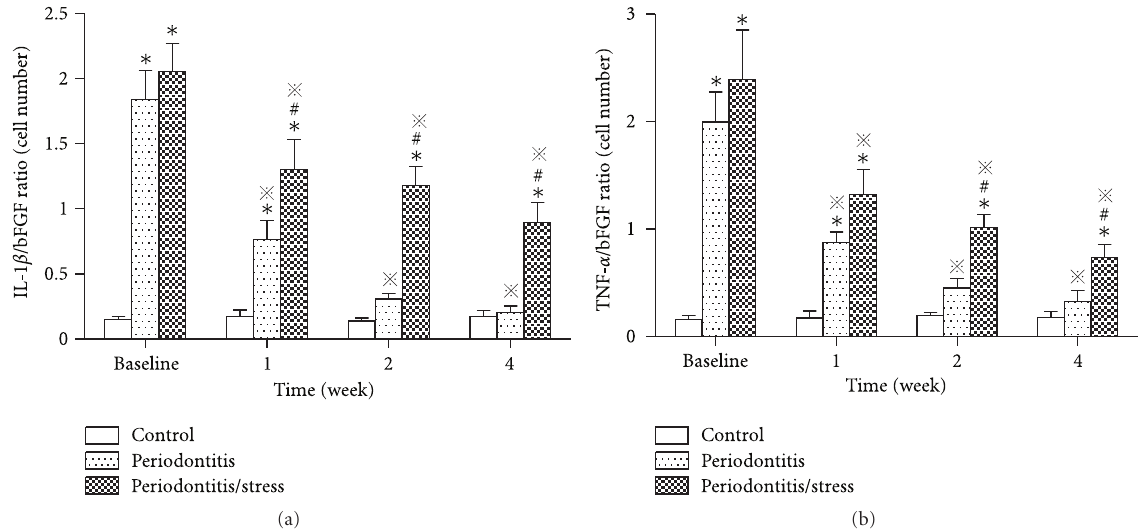
Figure 9: Ratios of immunoreactive cell numbers between inflammatory cytokines and bFGF during the observation period. (a) Immunoreactive cell number ratio between IL-1 β and bFGF. (b) Immunoreactive cell number ratio between TNF- α and bFGF. (cid:0) P versus control group at the same time point. # P at